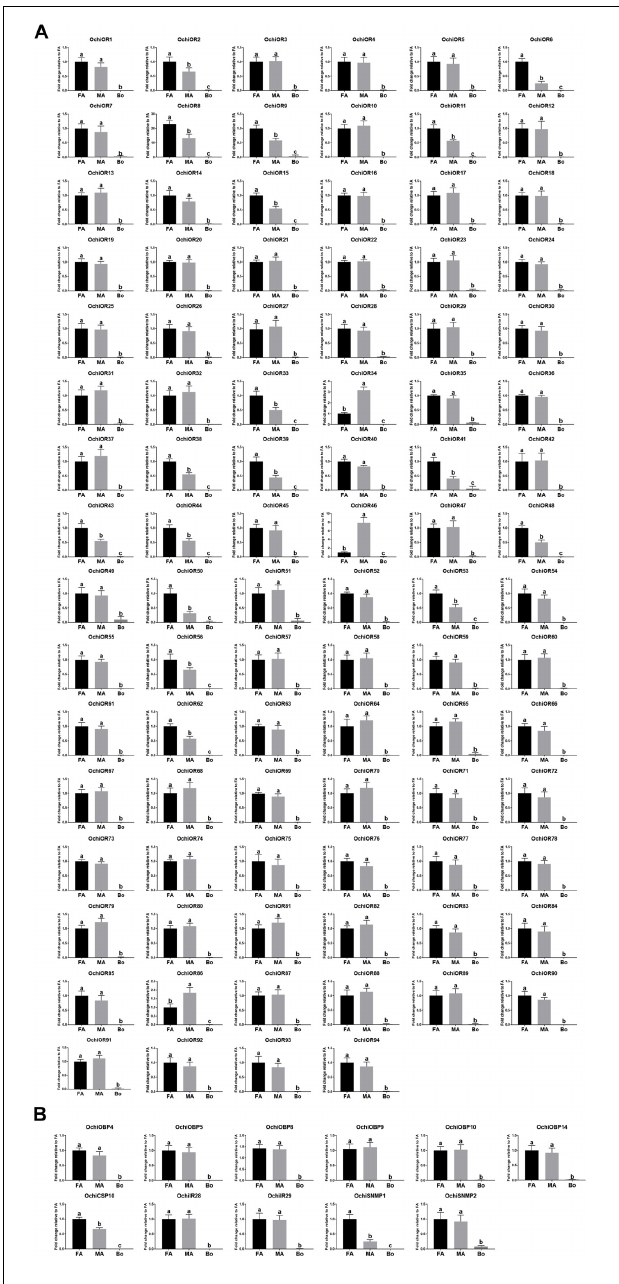
FIGURE 7 | Relative expression levels of the olfactory-related genes in the female antennae, male antennae, and other body parts from Oxya chinensis . (A) ORs. (B) SNMPs and the antenna-predominant candidates (OBPs, CSPs, and IRs). FA, female antennae; MA, male antennae; Bo, other body parts. The expression levels were estimated using the 2 − (cid:49)(cid:49) CT method. Bars represent standard error of three independent biological replicates with three technical duplicates for each replicate. Different small letters indicate statistically significant difference between tissues ( p < 0.05, ANOVA,